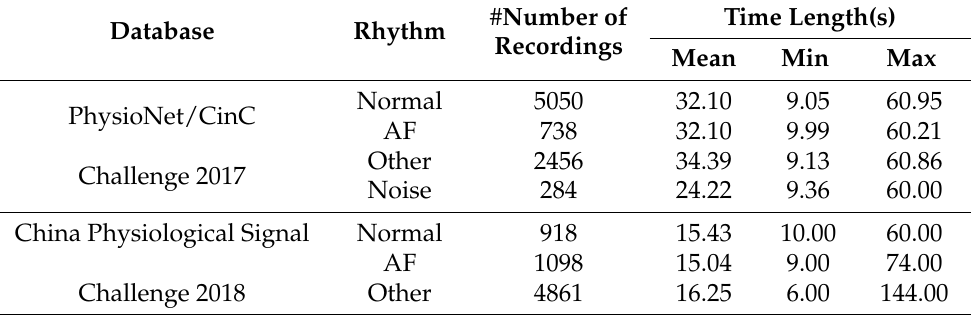
Table 1. Databases